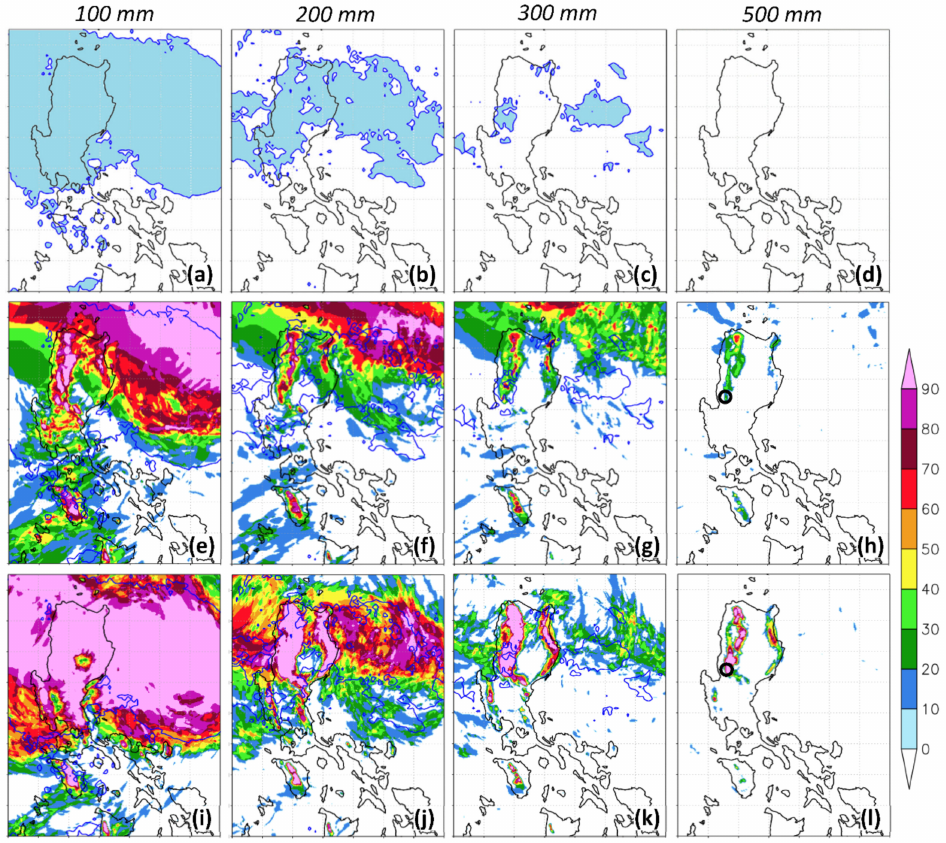
Figure 6. Areas to receive at least ( a ) 100, ( b ) 200, ( c ) 300, and ( d ) 500 mm of rainfall, respectively, during 14–15 September (in UTC) from TY Mangkhut (2018) in the GPM data (top row). Probabilities of 48 h QPFs (%, color) for the same period ( e – h ) to reach the four thresholds, respectively, from the first eight time-lagged members with t 0 up to 1800 UTC on 11 September (middle row), and ( g – l ) those from the last nine members with t 0 from 0000 UTC on 12 September to 0000 UTC on 14 September 2018 (bottom row). In ( e – l ), the observed areas in GPM are depicted by the dark blue contours, and the location of Baguio is marked with an open circle in ( h , l